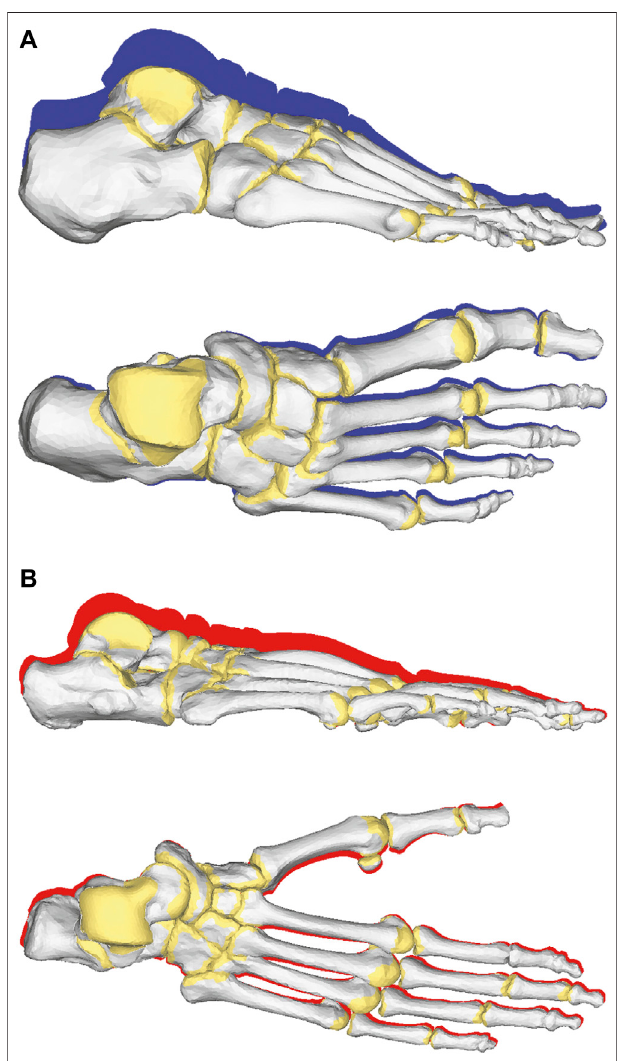
FIGURE 4 | Foot bone movements from respective initial positions during quiet standing in human (A) and chimpanzee (B) feet. Red and blue shades indicate foot bone contours at initial positions.